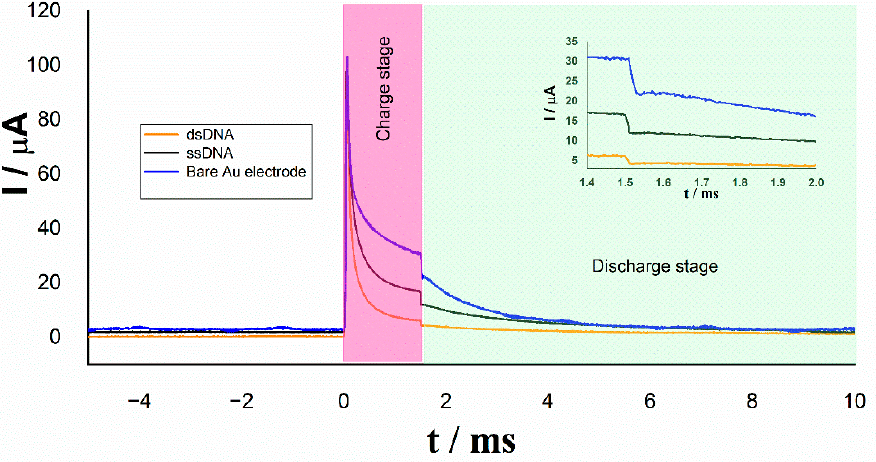
10 of 17 Figure 6. Relaxation voltage with external capacitor 𝐶 (cid:3042)(cid:3048)(cid:3047) on different electrodes. Analyzing the faradic and nonfaradaic current in each pulse by using the external capacitor as shown in Figure 7, at the first stage where the potential is being applied, we can appreciate the electric current demanded by resistor 𝑅 (cid:3047)(cid:3042)(cid:3047)(cid:3028)(cid:3039) (stationary state) and ca- pacitor 𝐶 (cid:3042)(cid:3048)(cid:3047) (transient state). When the potential step is canceled, we can see an abrupt change in current curve due to the switching of discharge current created by the M3 tran- sistor in its cut-off operating region. At this time, the decaying electric current is related to the resistance 𝑅 (cid:3047)(cid:3042)(cid:3047)(cid:3028)(cid:3039) , and the potential difference present on the capacitor 𝐶 (cid:3042)(cid:3048)(cid:3047) is ex- pressed in accordance with Equation (9). The inset in Figure 7 highlights the decrease in electric current due to the immobili- zation of the single strand DNA deposited on it (black line) with respect to the bare gold electrode (blue line). A greater decrease in current can be appreciated in the electrode after